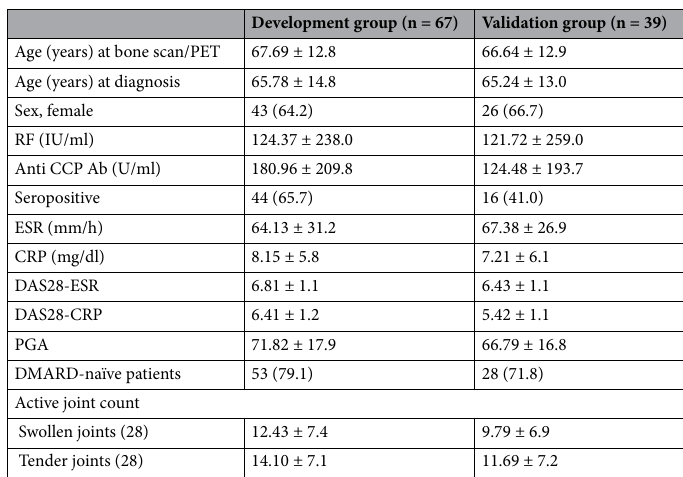
Table 1. Baseline characteristics of the study participants with rheumatoid arthritis Data are expressed as means ± SD for continuous variables or numbers and percentages for categorical variables. RF, rheumatoid factor; antiCCP anti-cyclic citrullinated peptide, ESR erythrocyte sedimentation rate, CRP C-reactive protein, DAS disease activity score, PGA patient global assessment, DMARD disease-modifying antirheumatic